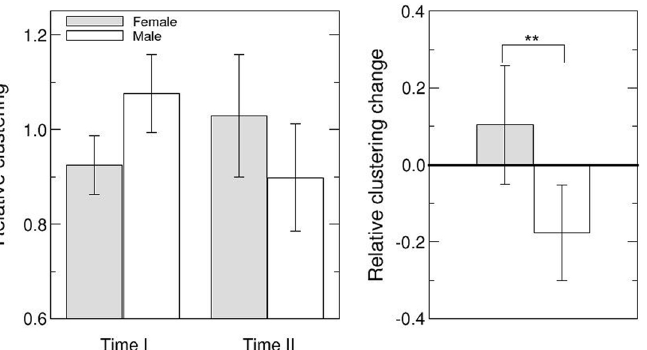
Fig 4. Analysis of the relative clustering (RC) around leaders. The left plot shows mean RCs at Time I and Time II for male and female leaders(see legend).Error bars indicate the mean standard error. The right plot shows changesin RC for males and females. Note that the changein leaders’RC is significantly different for males and females ( p < .05).